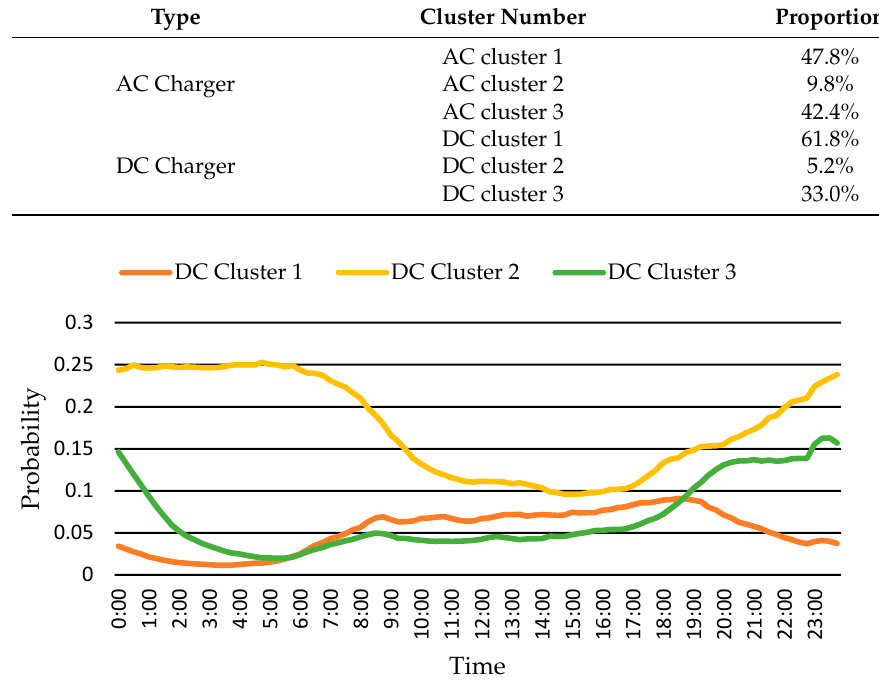
Figure 3. EV-user segmented groups of DC chargers.